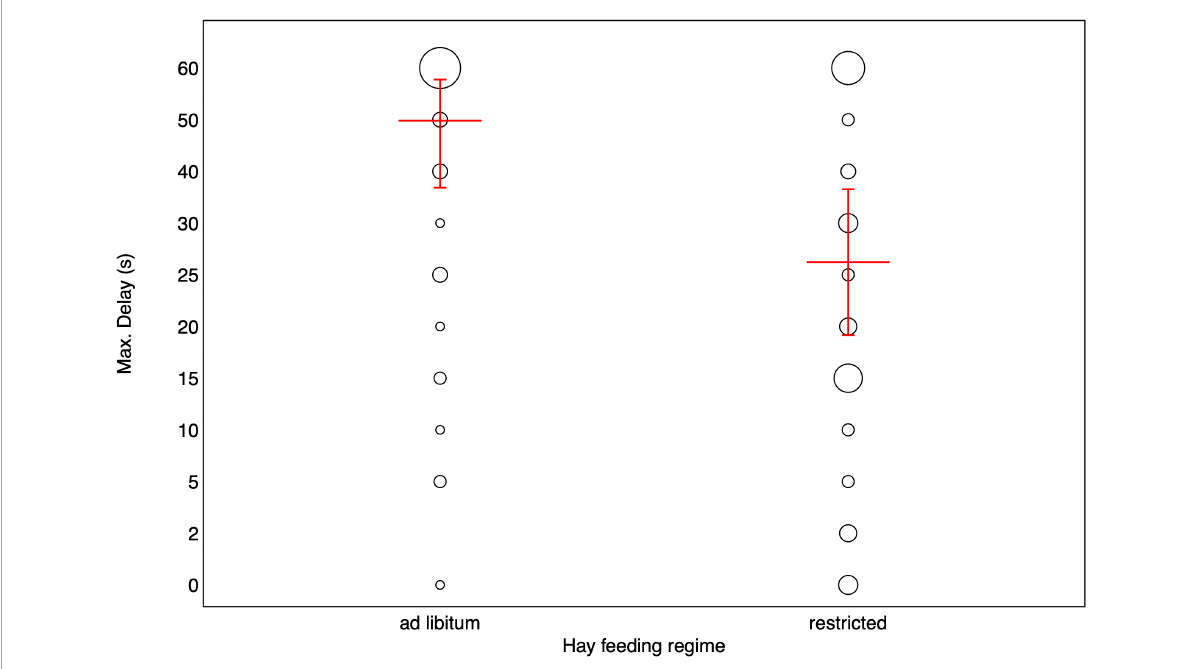
piece of reward) and a delayed high quantity reward (HQR; 5 pieces of reward). These quantity differences were selected as horses have been shown to successfully discriminate between